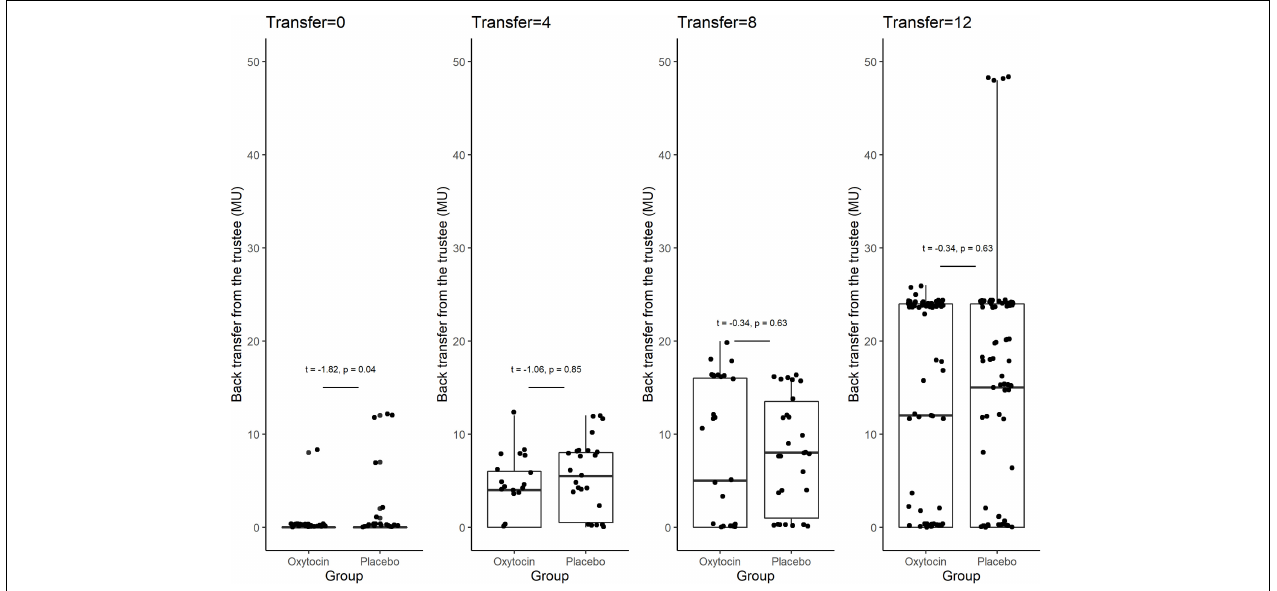
FIGURE 3 | Box plots of back transfer. The back transfer for different invested amounts is indicated separately for the oxytocin and placebo groups. For each plot, the middle horizontal line denotes the median value; the box extends from the 25th to the 75th percentile values; the vertical lines extending from the box denote adjacent values (i.e., the most extreme values within 1.5 interquartile of the 25th and 75th percentile of each group); and the dots denote back transfers. For the different non-zero invested amounts, we observed no significant difference in the mean back transfer between trustees in the oxytocin and placebo groups [transfer = 4, 4.090 vs. 5.269, t ( 46 ) = − 1.06, P = 0.85, one-sided; transfer = 8, 7.355 vs. 7.967, t ( 59 ) = − 0.34, P = 0.63, one-sided; transfer = 12, 12.516 vs. 13.258, t ( 182 ) = − 0.42, P = 0.66, one-sided]. For transfers of 0 MU, the participants in the oxytocin group returned less MU than those in the placebo group [0.167 vs. 1.070, t (